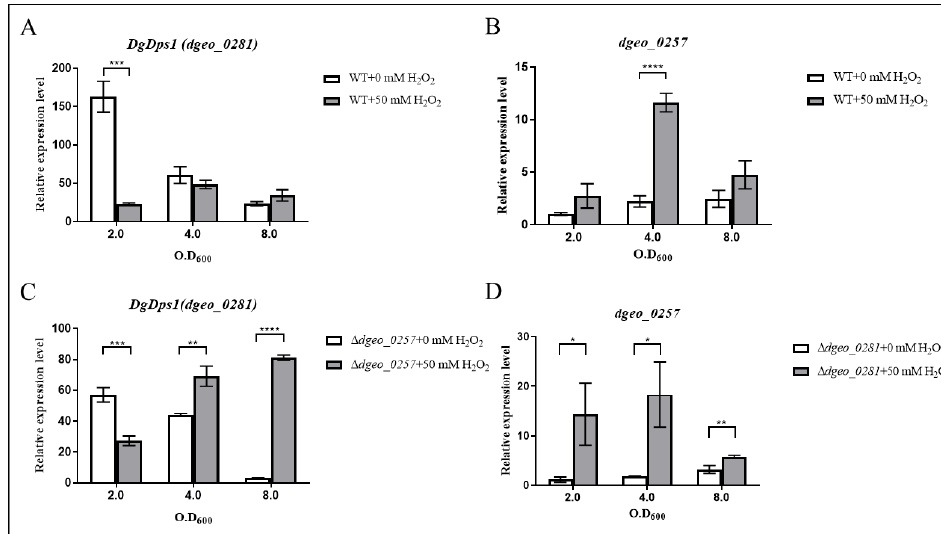
Figure 6. Expression levels of both DgDps1 ( dgeo _0281) ( A , C ) and a putative Dps ( dgeo _0257) ( B , D ) in the presence or absence of 50 mM H 2 O 2 in the wild-type strain and in Δ dgeo _0257 and Δ dgeo _0281 mutants at three different growth phases, OD 600 2.0, 4.0, and 8.0, by qRT-PCR analysis, respectively. The probability t -test was considered significant at p < 0.05 (*), p < 0.01 (**), p < 0.001 (***), and p < 0.0001 (****).